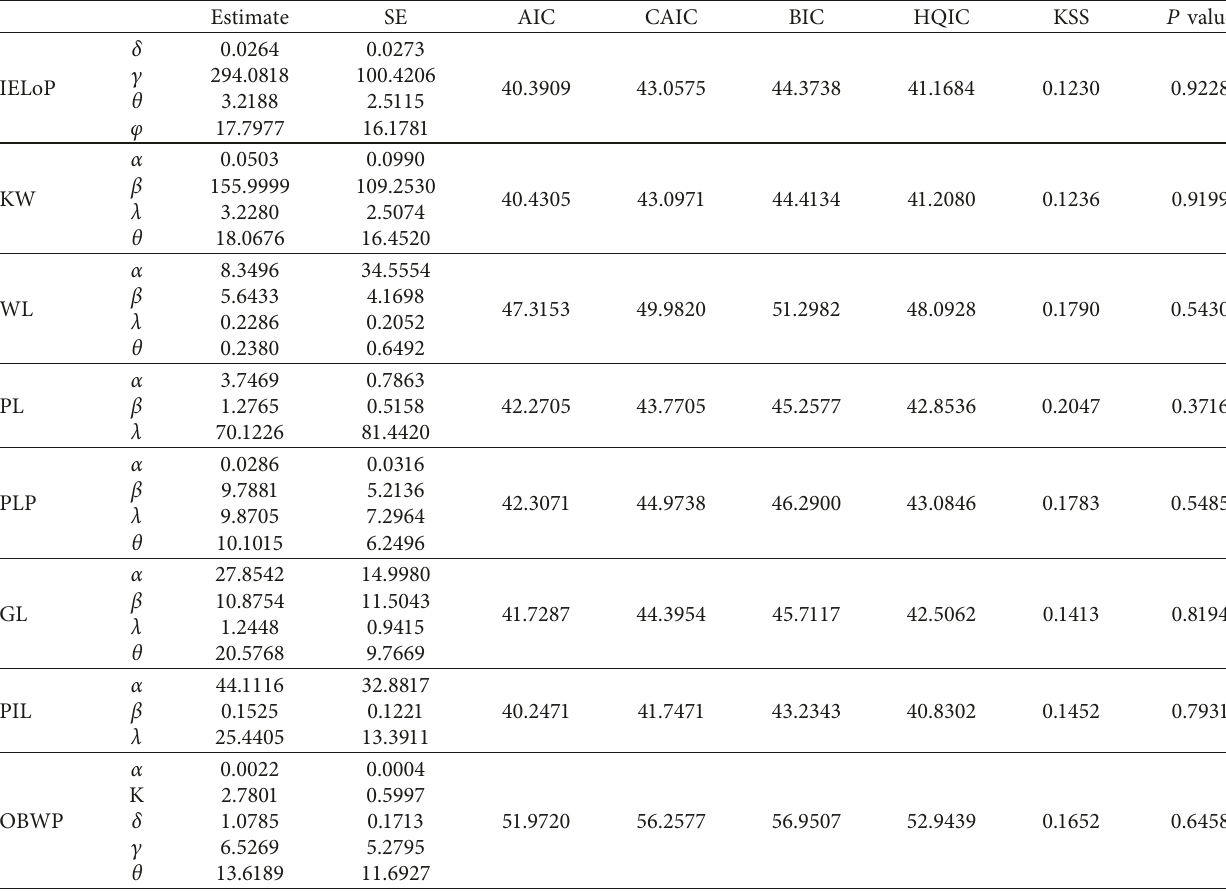
Table 8: MLE, SE, different measures, and KSS test for the fitted models for dataset I.